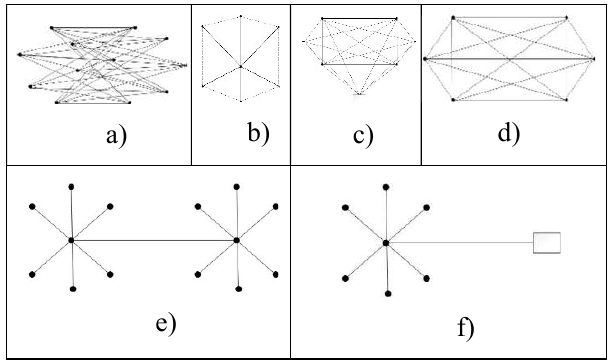
Figure 1. Network classification according to (a,b,c,d,e,f)